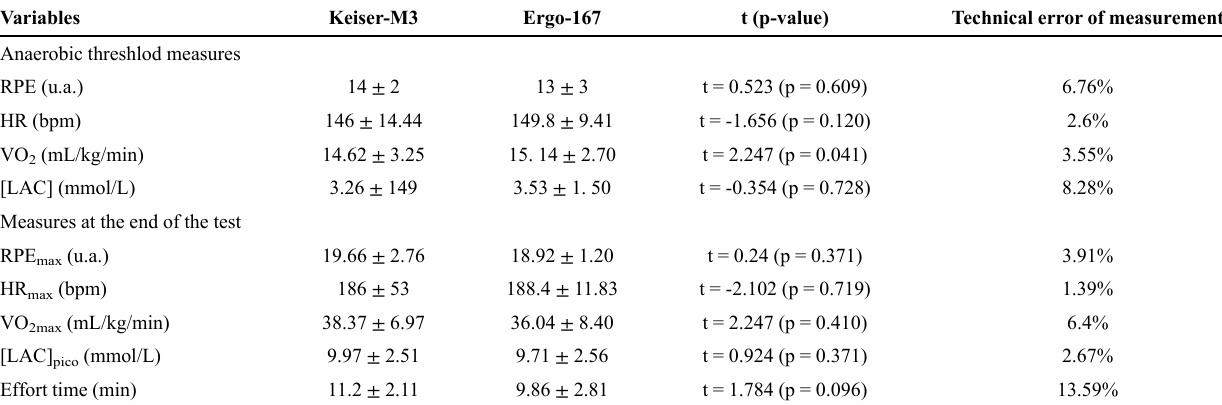
Table 1 - Descriptive data of the sample, considering each ergometer (n = 15).